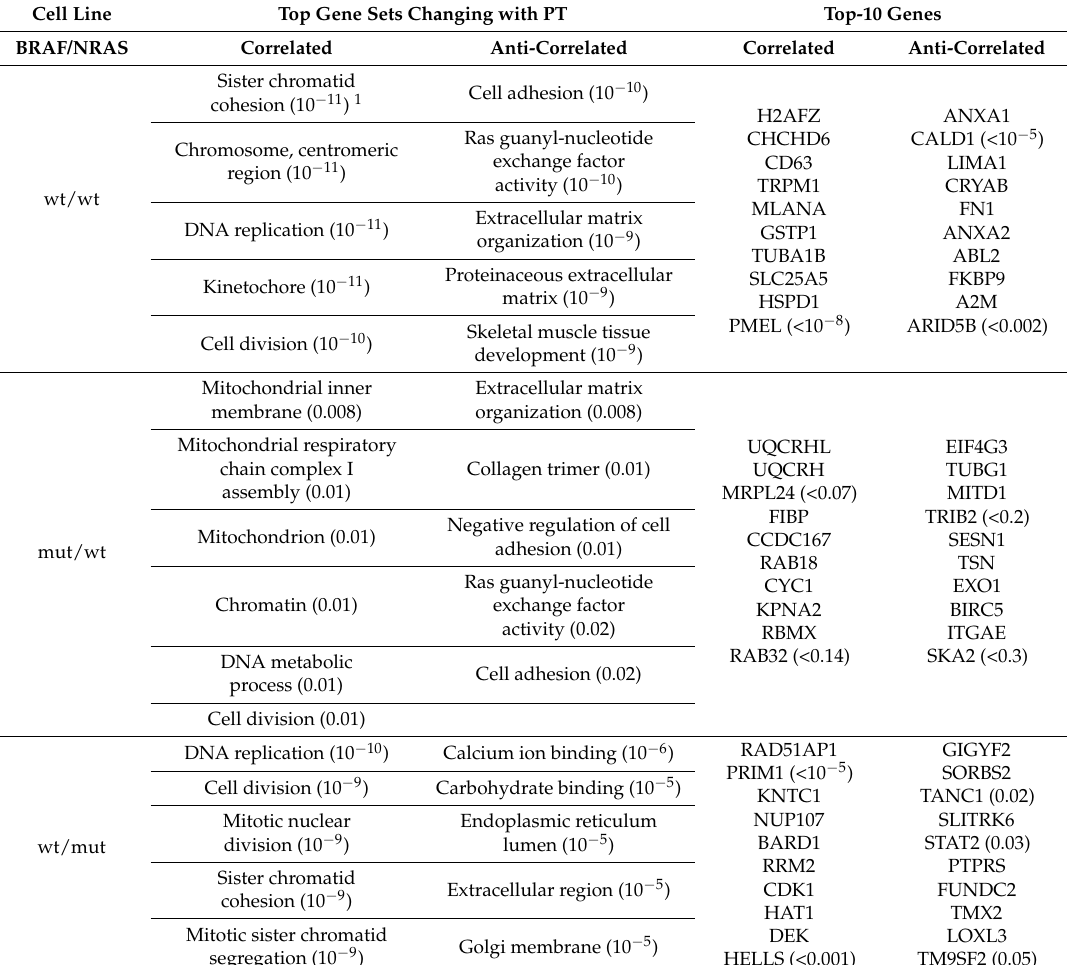
Table 1. Gene sets and top genes varying in concert with